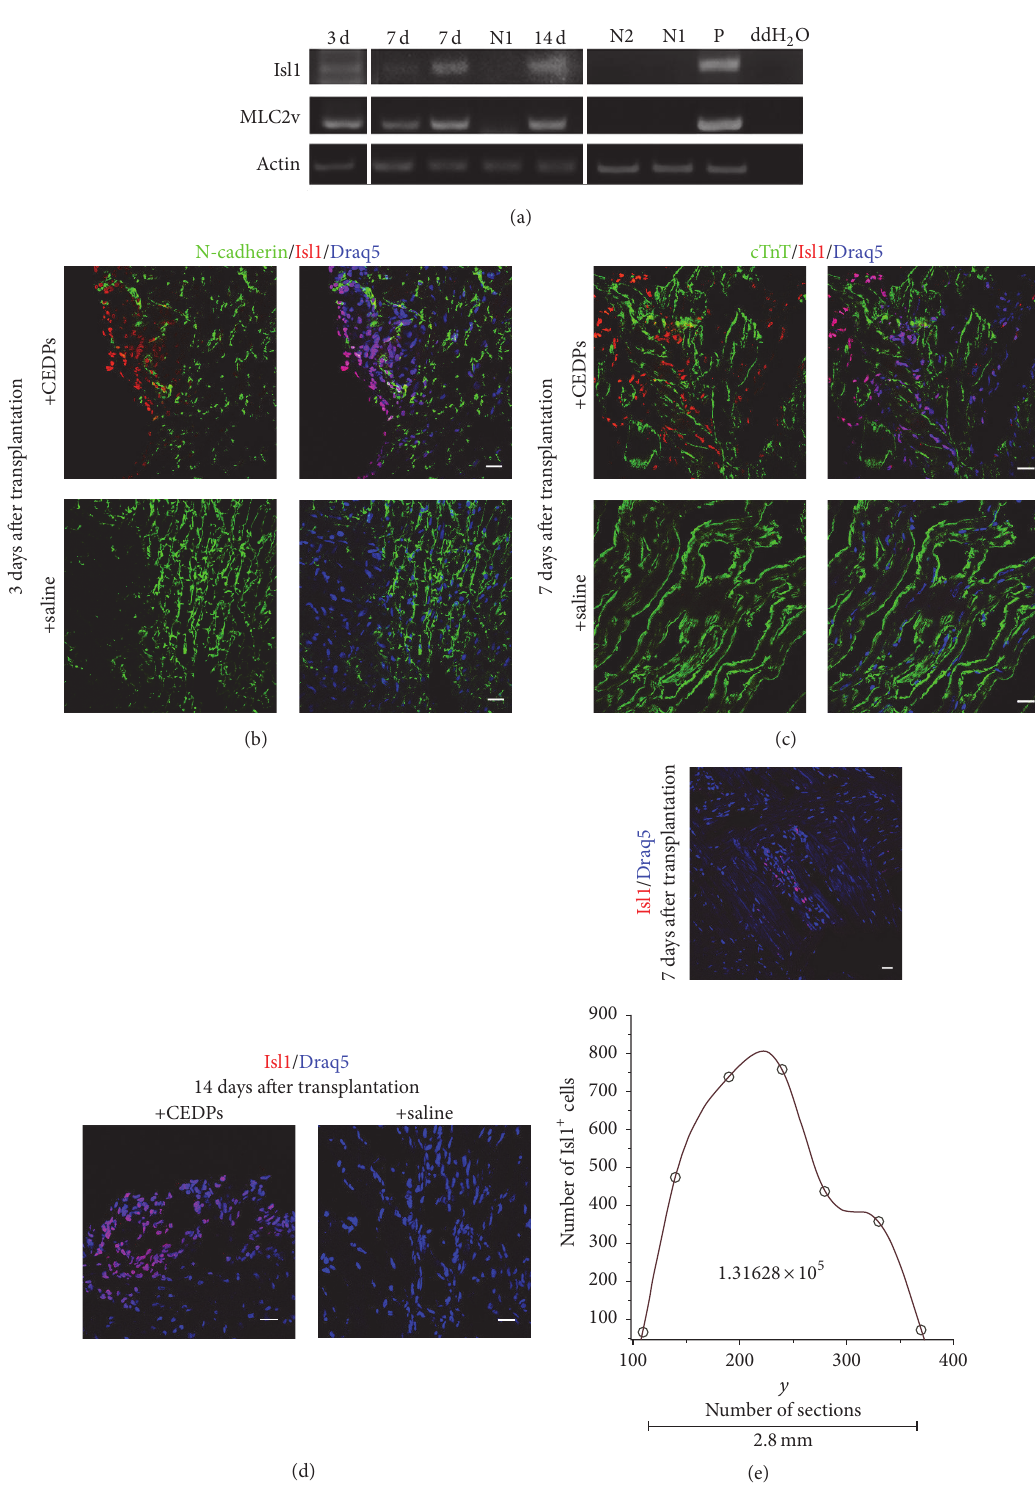
Figure 7: Transplantation of CEDPs in adult rats’ heart. (a) Expression of Isl1 and MLC2v after 3, 7, and 14 days of transplantation by RT- PCR analysis. mRNA from saline-injected immunosuppressed (N1) or untreated (N2) LV of adult rats was used as negative controls and mRNA from E12 mouse embryos (P) as positive control. (b–d) Clusters of Isl1 + cells derived from CEDPs were detected in frozen sections of LVs isolated 3, 7, and 14 days after transplantation. Sections were stained for DNA with Draq5 and with anti-N-cadherin (b) and anti-cTnT (c). Sections from isolated LVs of saline-injected immunosuppressed rats were used as control for each time-point. (e) All Isl1 + cells from two nonsequential sections were photographed (as in representative upper image) and counted with Fiji cell-counter. Draq5 used for DNA staining. The total Isl1 + cell number found in 2.8 mm tissue was calculated after spline interpolation. Scale bar: 20 𝜇